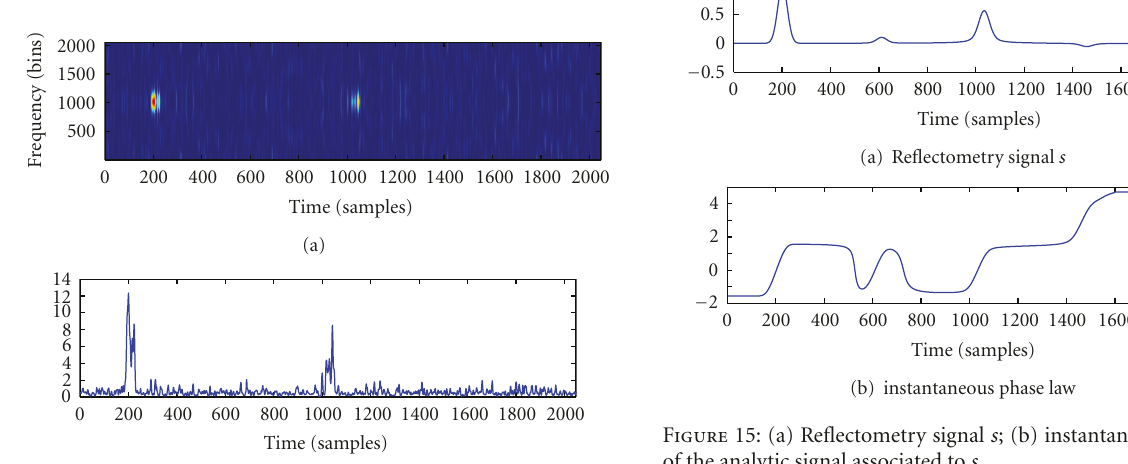
Figure 12: (a) Spectrogram of the reflectometry signal noised at SNR = 30db; (b) associated detection curve.